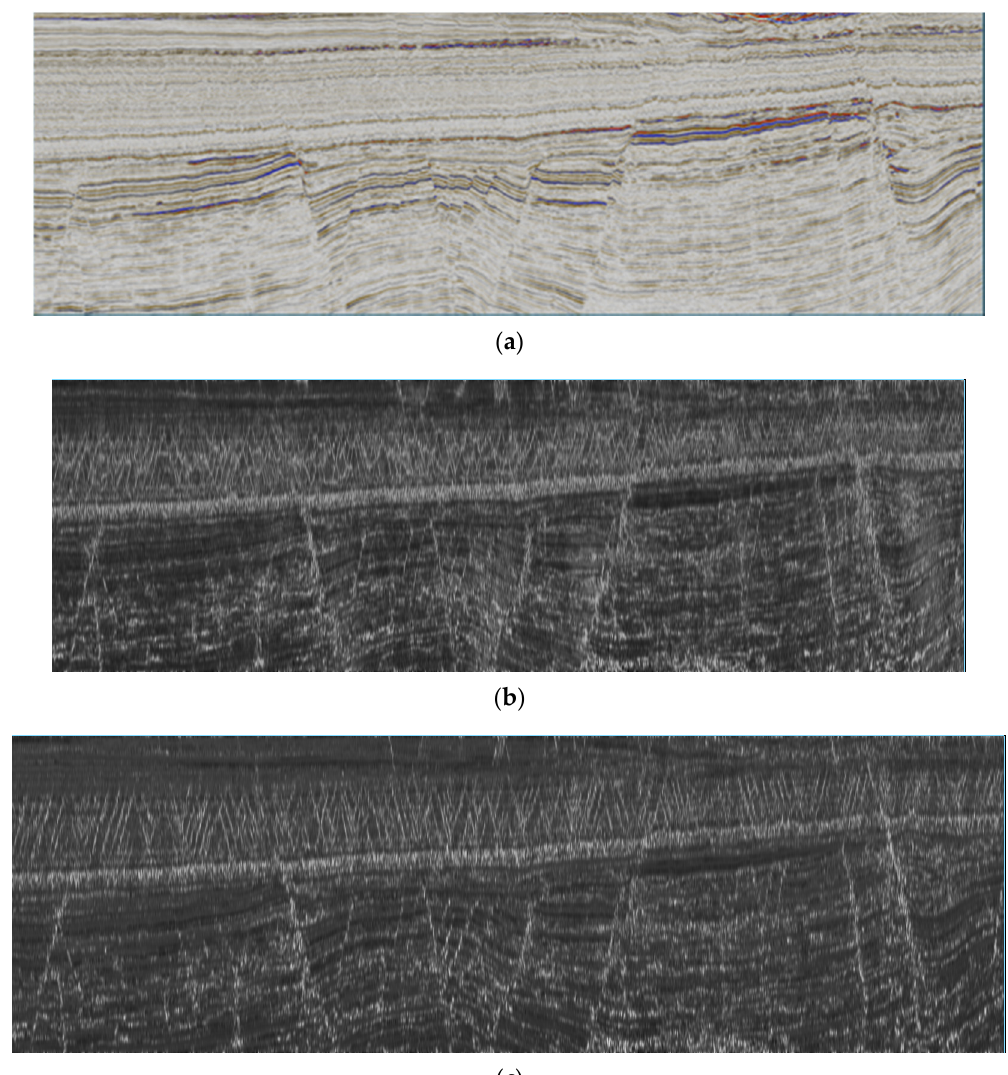
Figure 4. ( a ) Original cube section and the results of edge detection using amplitude contrast attribute with ( b ) nondirectional and ( c ) directional and summation steps.